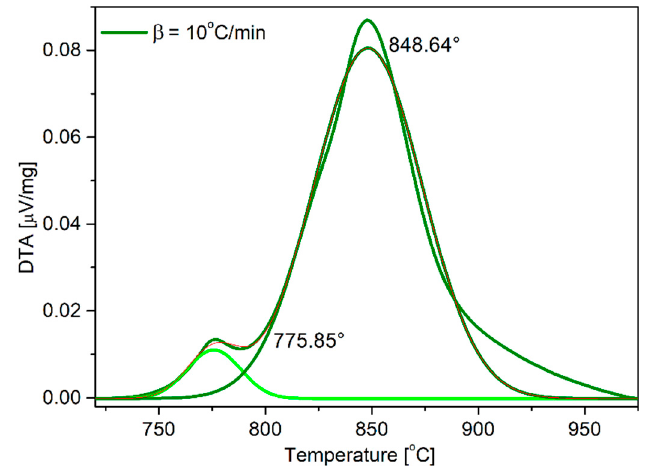
Figure 8. DTA crystallization curves ( a ) (heating rate: 2.5, 5, 10, 15 with steps of 20 °C/min) and the interpretation of kinetic evaluation with the Kissinger equation ( b ) of pure GeO 2 glass.